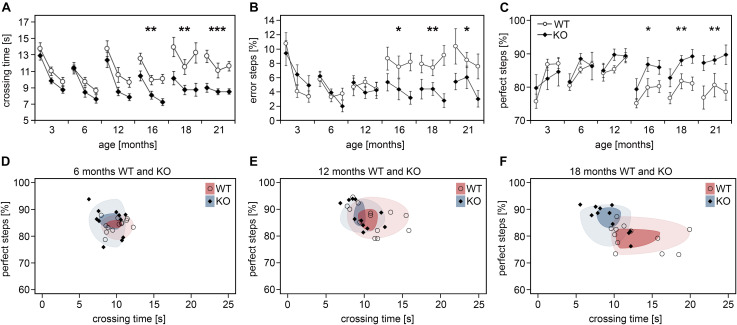
Aged Pvalb-Cre/tdTomato/Dnmt1 KO mice show improved somatomotor performances. (A–C) Performance of Pvalb-Cre/tdTomato/Dnmt1 KO (N = 10) and WT (N = 8) mice were tested in the inclined ladder rung test at distinct stages of life ranging from 3 to 21 months (three consecutive trials per stage). Crossing time (A), error steps (B), and perfect steps (C) were quantified (two-way ANOVA; data are shown as mean ± SEM; *P < 0.05, **P < 0.01, ***P < 0.001). (D–F) The scatter plots of perfect steps against crossing time for the distinct Pvalb-Cre/tdTomato/Dnmt1 KO and WT mice at 6 months (D), 12 months (E), and 18 months (F) illustrate the stronger segregation of the cohorts with age shown by the decreasing overlap of the circles upon aging representing the 1st (dark colored) and 3rd quartile (light colored) of the data range per group.